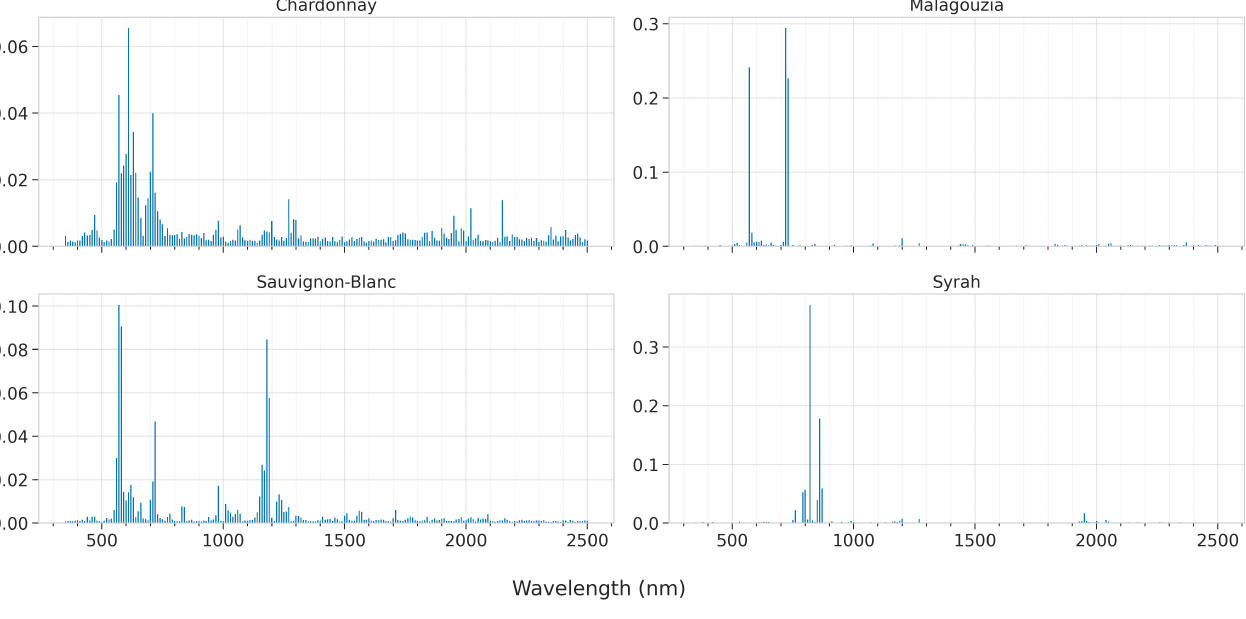
Figure 13. Mean feature importance according to Gini values (also known as impurity-based impor- tances) for the best Random Forest model across the five folds and for each of the four grape varieties; the higher the bar, the more informative the feature about the °Brix